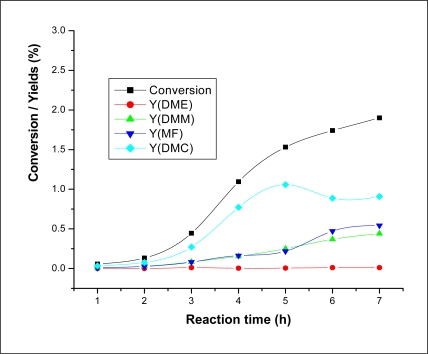
Conversion and DMC yield versus reaction time. Reaction conditions: m (catalyst) = 0.1 g; PCO2 = 2.5 bar.